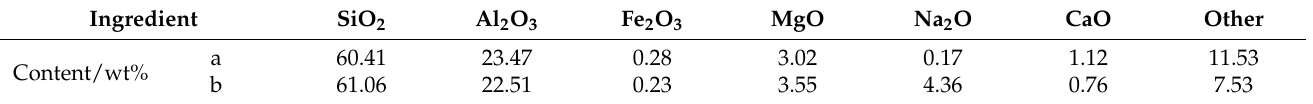
Table 1. Chemical composition of the (a) MMT and (b)